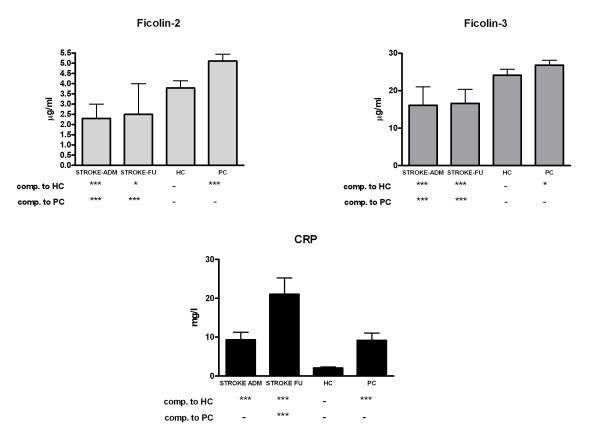
Concentrations of ficolin-2, ficolin-3 and C-reactive protein in the sera of patients with acute ischemic stroke. Concentrations at the time of hospital admission and on day 3, as compared to healthy controls (HC) and patient controls (PC, patients with > 70% stenosis of the carotid artery without acute stroke) are shown. P values (* < 0.05, *** < 0.01) for the non-parametric Kruskal-Wallis test followed by the Dunn post hoc test are indicated.